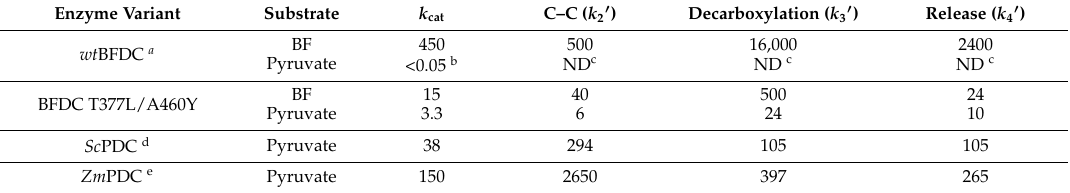
Figure 2. The C6 ′‐ H singlet signals of ThDP (thiamin diphosphate) and of pyruvate ‐ conjugated covalent intermediates were used for the assignment and quantitative analysis of the following intermediates: ThDP (8.01 ppm), LThDP (lactyl ‐ ThDP) (7.27 ppm), HEThDP (2 ‐ hydroxyethyl ‐ ThDP) (7.34 ppm) and ALThDP (2-acetolactate-ThDP) (7.30 ppm). Intermediates and cofactor were isolated by acid quench after a reaction time of 8 s and analyzed by 1 H NMR at pH 0.75 at 25 ◦ C as described in Materials and Methods. Relative concentrations of intermediates were determined from the relative integrals of the corresponding signals, which were used to calculate all microscopic rate constants of the catalytic cycle. Table 2. Net rate constants (s − 1 ) for reaction of BFDC and PDC variants with benzoylformate and pyruvate.